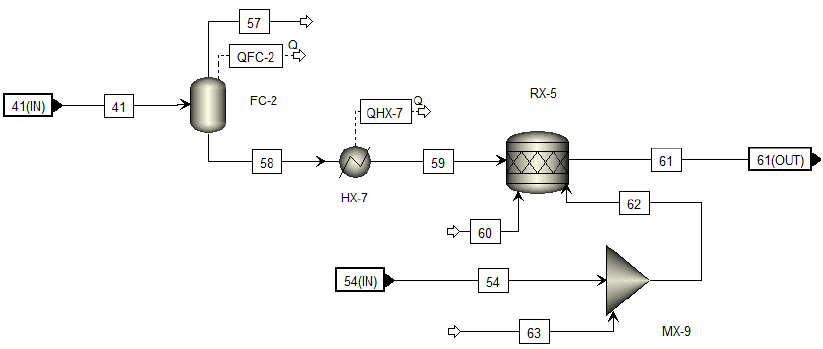
Figure 10. Six carbon fermentation flowsheet in topology 2.